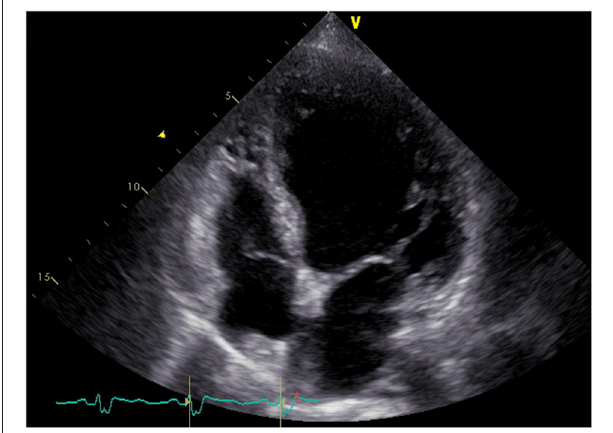
FIGURE 2 | Four-chamber echocardiogram showing a dilated left ventricle.